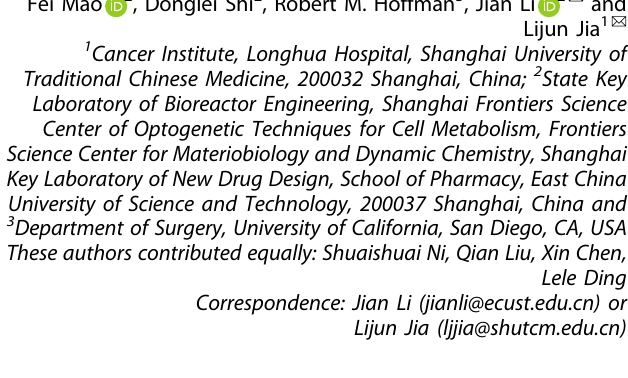
Fig. 1 MLN-driven bifunctional prodrug combination strategy is an improved senescence-focused anticancer combination therapy. a Schematic depicting the pro-senescence evaluation process of MLN. b Evaluation of the pro-senescence activity of MLN in lung cancer cell lines A549, H1299 and normal lung cell line BEAS-2B by SA- β -gal staining. The results are representative of three independent experiments. Bar graphs represent ratio of SA- β -gal positive cells. Scale bar: 20 μ m. c Synergistic ef fi cacy of 92 approved anticancer drugs with MLN in A549 (blue), Huh7 (orange), and MCG803 (green) cell lines. Q represents the value of combination ef fi cacy, values >1.15 indicate synergy, values <0.85 antagonism, values at 0.85 – 1.15 indicate an additive effect; Structure of optimal synergistic drug linifanib (LIN). d Colony formation assay and statistical data to compare the synergistic antiproliferative effect of LIN in combination with MLN on A549, H1299 and BEAS-2B cell lines. e Colony formation assay and statistical data to compare the antiproliferative activities of LIN or Gal-LIN in combination with MLN on A549, H1299 and BEAS-2B cell lines. f Proposed activation mode of Gal-LIN to release LIN by MLN-induced SA- β -gal. g Schematic representation of combination administration on A549 bearing mice. Six different regimens, including mock group, three single- administration and two combination-administration groups, were performed with a metronomic schedule. The mice in two combination groups were treated with MLN in advance for 7 days, and then alternately combined with either LIN or Gal-LIN, for six days with an one-day rest as the treatment cycle. h Tumor volume change during treatment. The combination of MLN and Gal-LIN exhibited better tumor growth inhibition percentage (TGI) than either drug alone (70.49% vs 30 – 50%), comparable with the combination of MLN and LIN (76.53%) (left). Mice body weight change during treatment (right). i Images of tumors from mice at the 30th day after initiation of treatment. j Tumor volume change during treatment. Three regimens, including mock group, the combination group of MLN with LIN or Gal-LIN, were performed with a metronomic schedule. Once tumors reached an average volume of ~400 mm 3 , mice were treated with MLN in advance for 3 days, and then treated with either LIN or Gal-LIN for 12 days. k Mice body weight change during treatment. The combination of MLN and LIN caused a signi fi cant decrease of the weight ratio of liver to body ( P < 0.05). l Organ/body weight rate after 15 day of treatment. m Liver and kidney functional tests; UREA; Cr creatinine, ALT alanine aminotransferase, AST aspartate. n Schematic illustration of MLN-induced β -gal